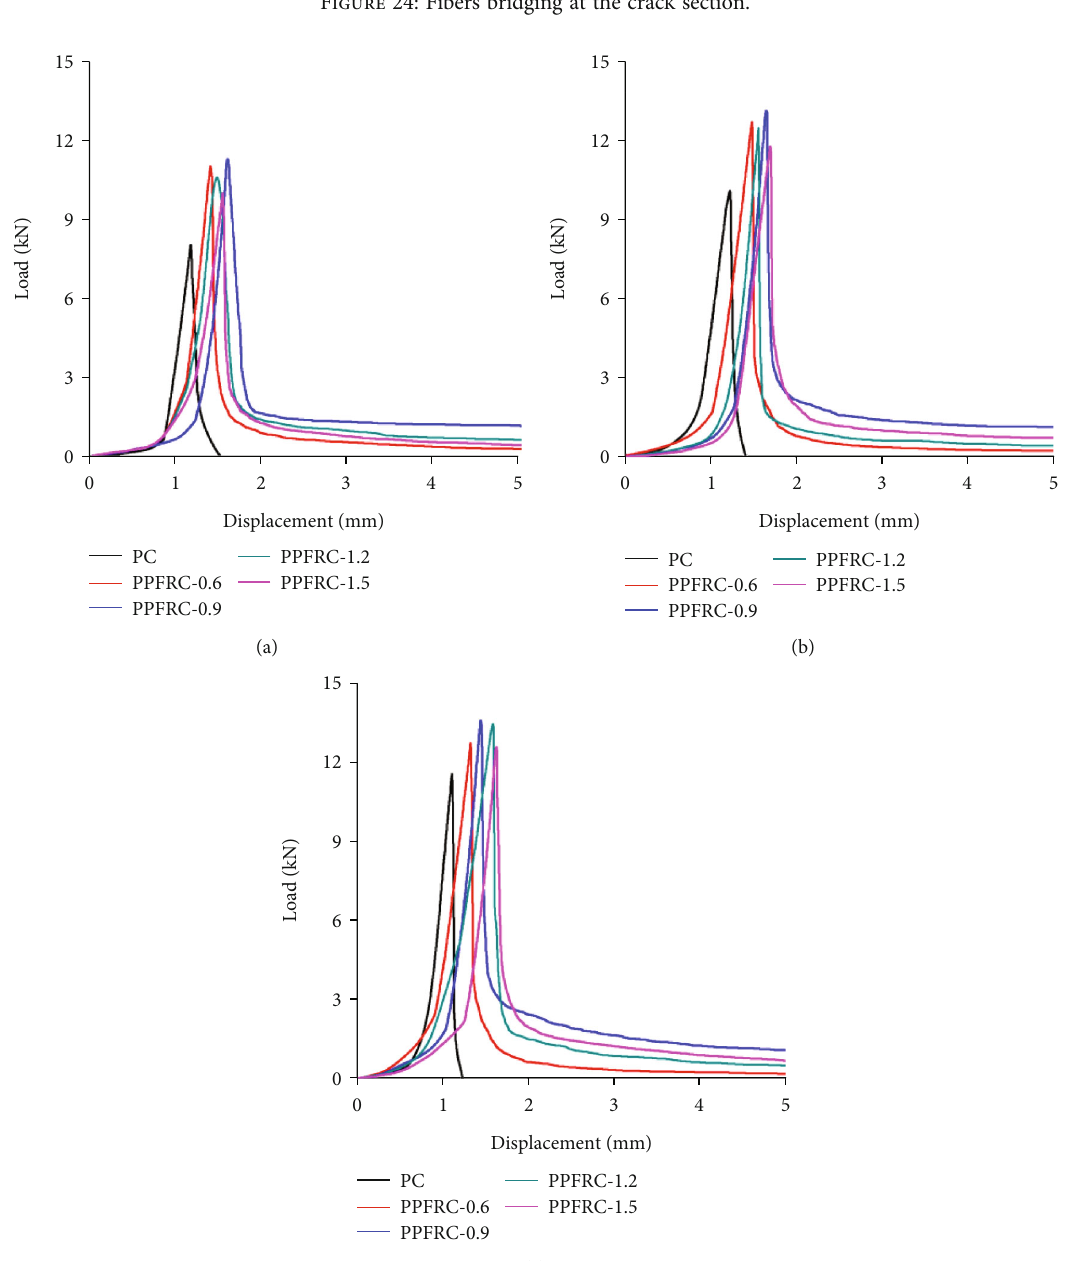
Figure 25: Load – time curves of PC and PPFRC from fl exural test: (a) 14 days, (b) 28 days, and (c) 60